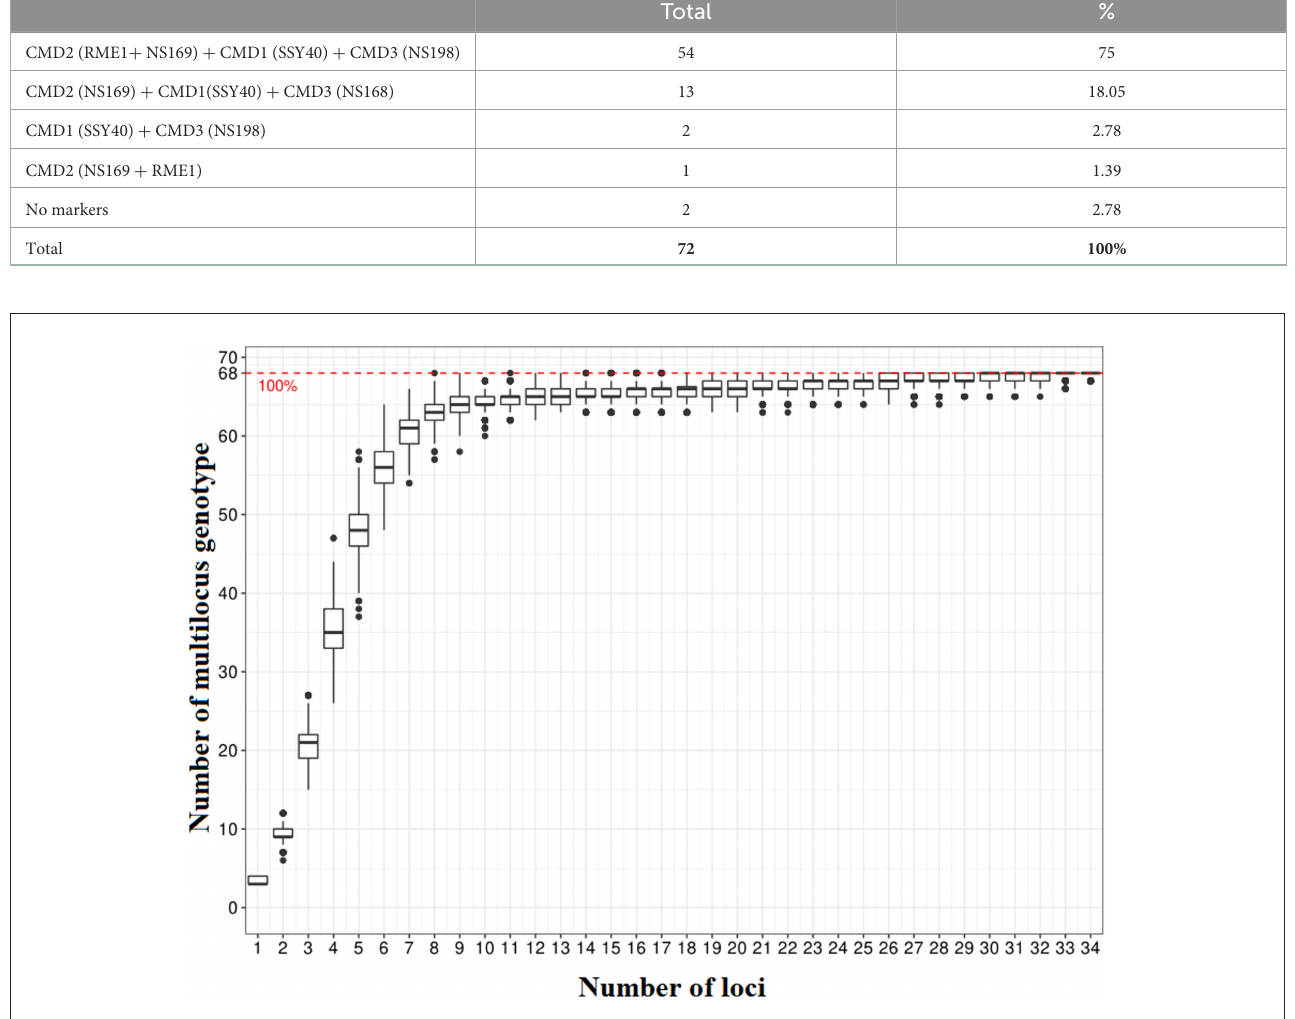
FIGURE5 Genotype accumulation curve showing the minimum number of SNPs (8) needed to differentiate all unique genotypes.